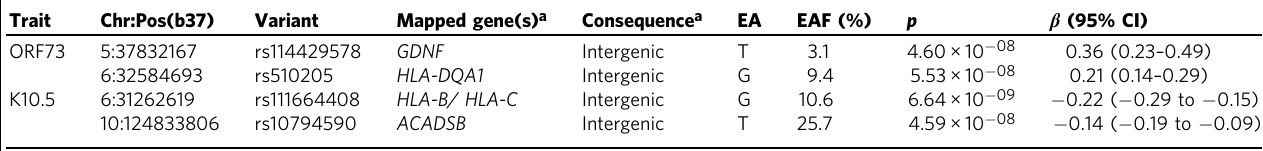
Table 2 Lead association signals with anti-KSHV IgG antibody